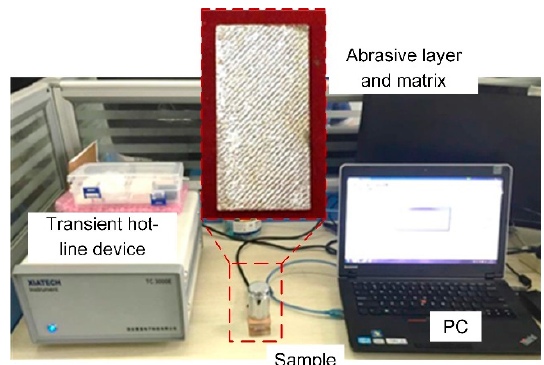
Figure 4. Thermal conduction measurement of the abrasive layer with matrix.